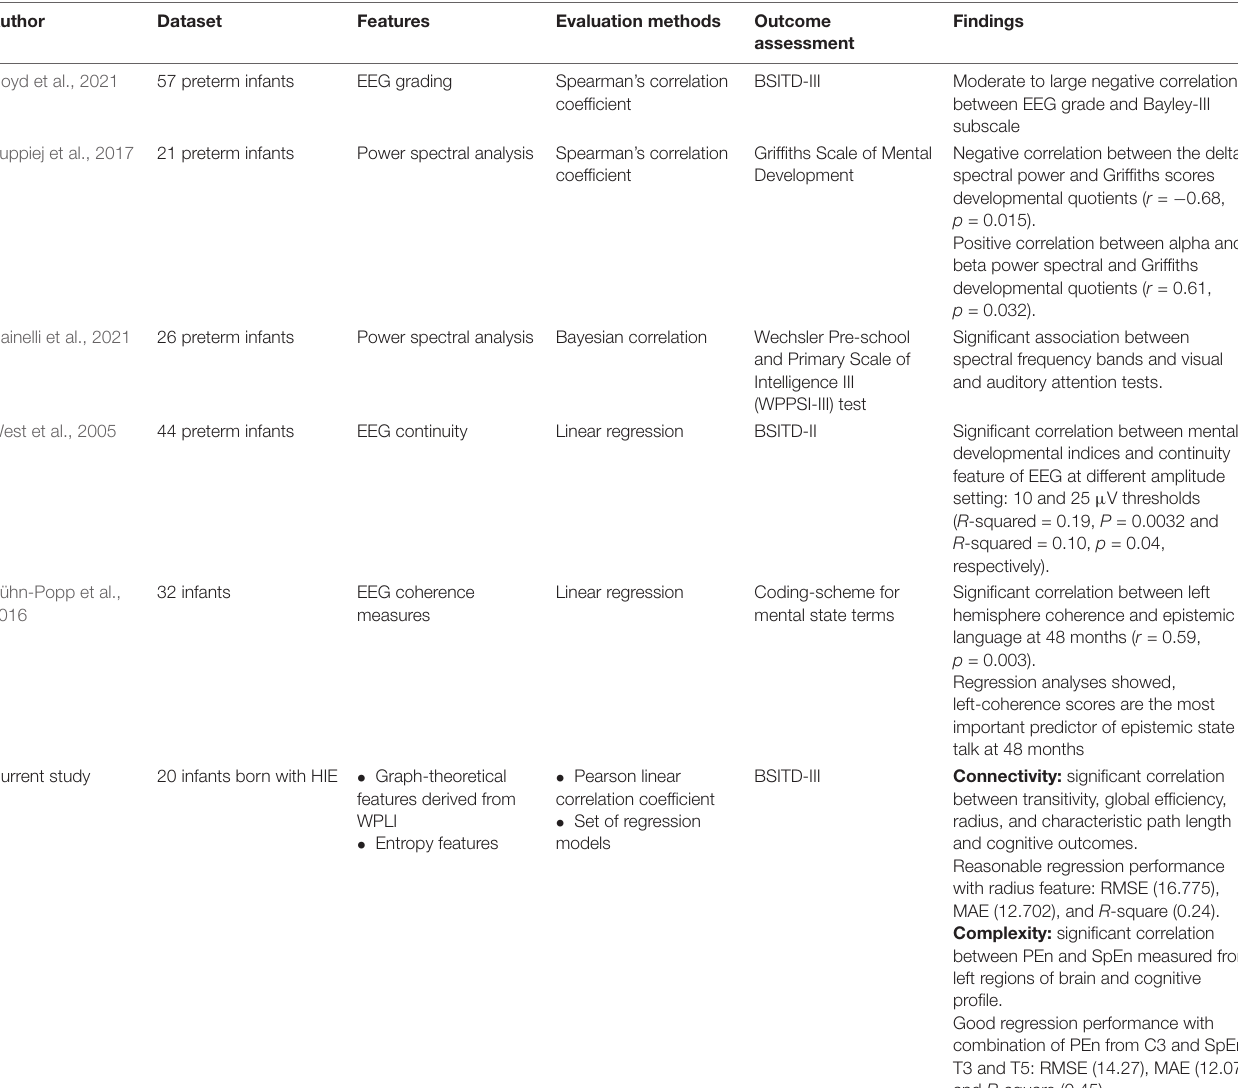
TABLE 7 | Comparison of the qEEG state-of-the-art methods employed for predicting cognitive